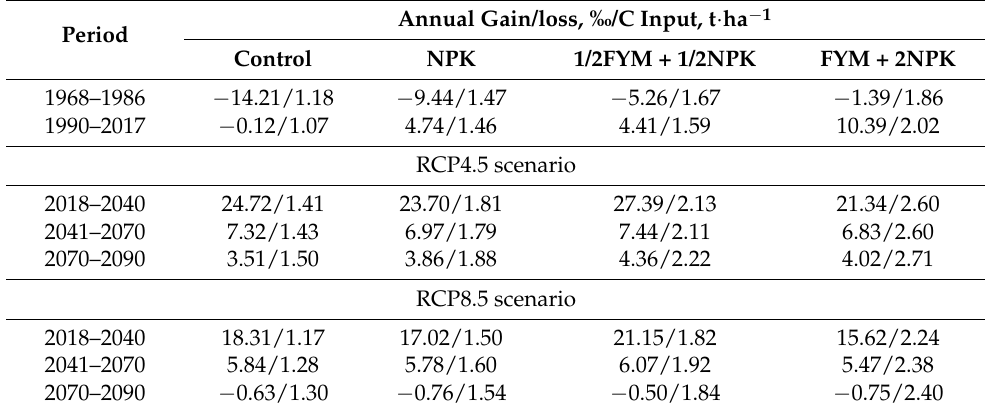
Table 5. Annual gain/loss and input of C in the variants of the experiment,